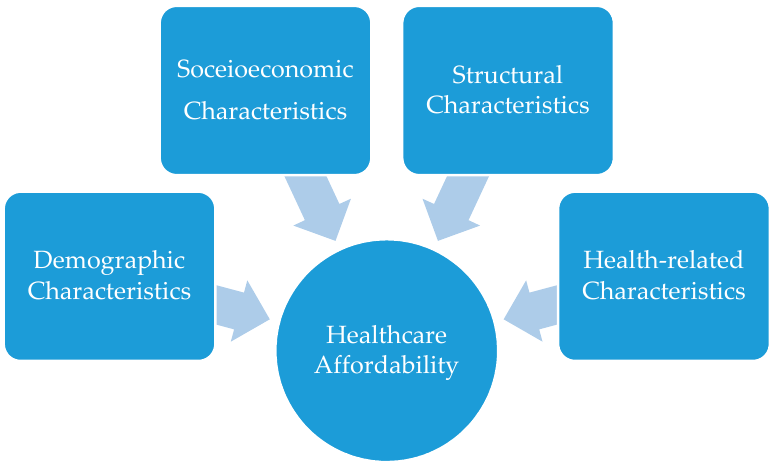
Figure 1. Main demand-side factors affecting healthcare affordability.